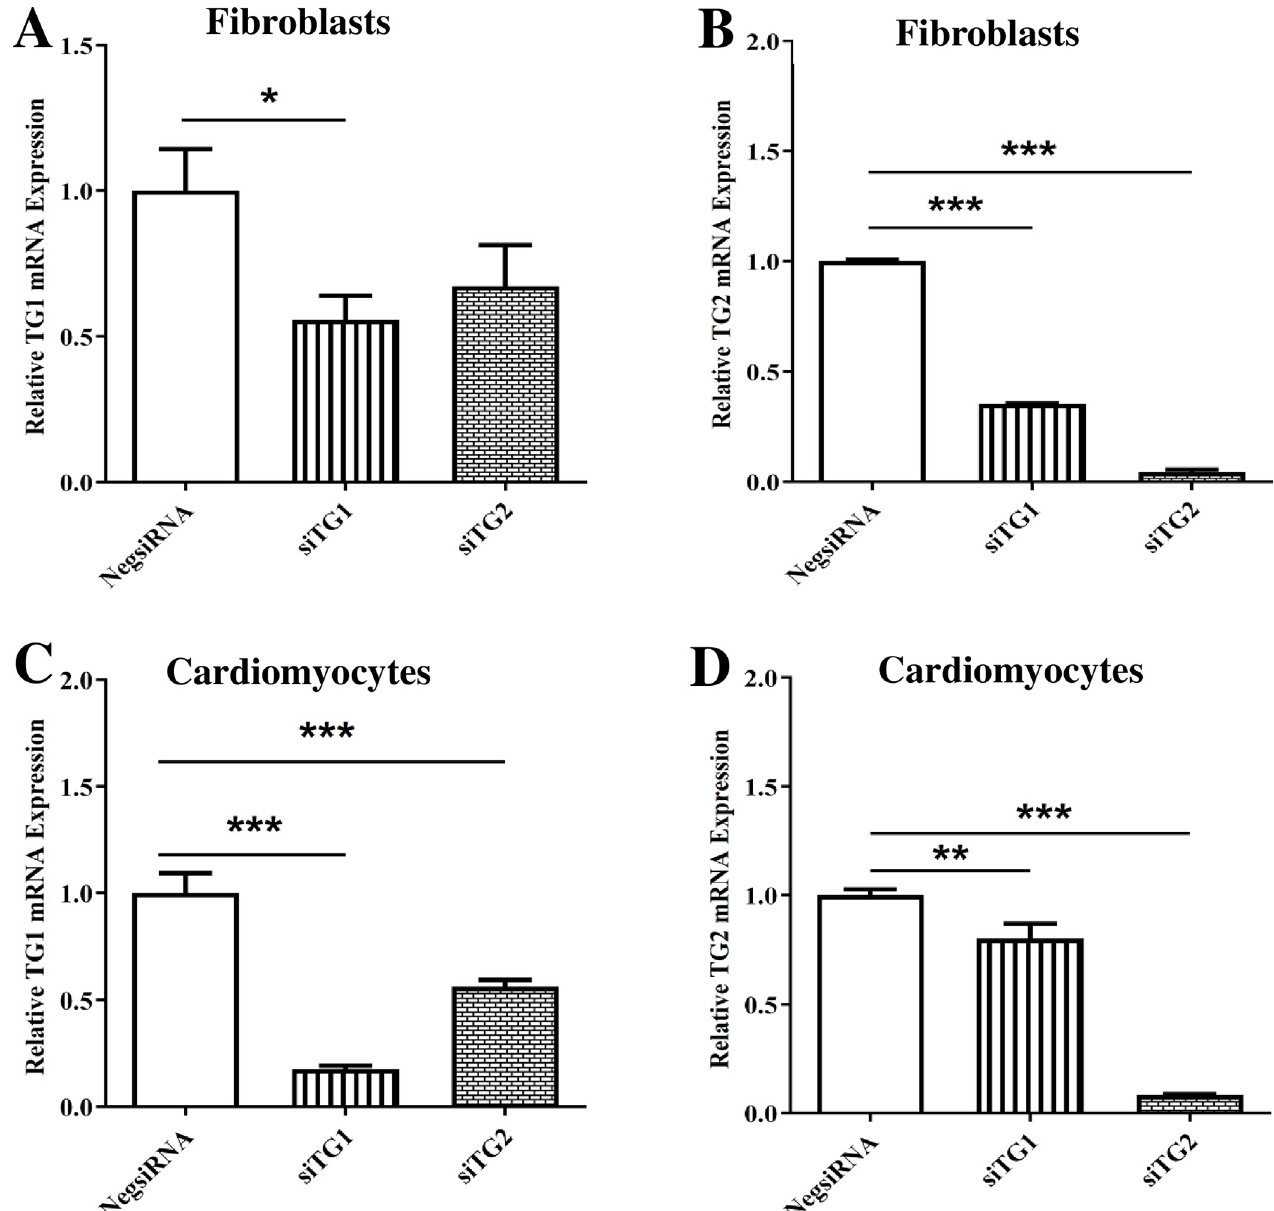
Fig 1. Transglutaminase 1 (TG1) and TG2 expressions were efficiently suppressed in neonatal rat ventricular fibroblasts and cardiomyocytes using individual small interfering RNA (siRNA) for downregulating TG isoforms. The specificity and efficiency of TG1 and TG2 knockdown were estimated by qPCR following transfection of neonatal rat ventricular fibroblasts and cardiomyocytes (n = 4 replicates). Effect of transfection with siTG1 or siTG2 on the relative TG1 and TG2 mRNA levels in fibroblasts (A and B) and cardiomyocytes (C and D) as compared with the negative control (NegsiRNA). The abundance of TG1 and TG2 mRNA was normalized to that of β 2 microglobulin. Results are means ± SEM; unpaired Student’s t-tests were performed. � P < 0.05; �� P < 0.01; ��� P < 0.001 vs. NegsiRNA.